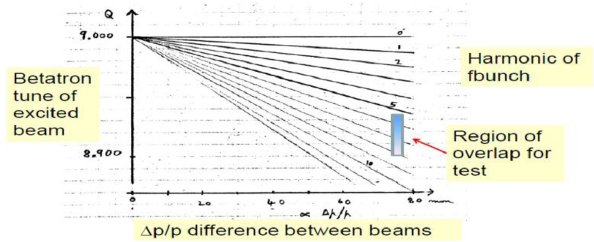
FIG. 16. The OLKO resonance conditions for the ISR.